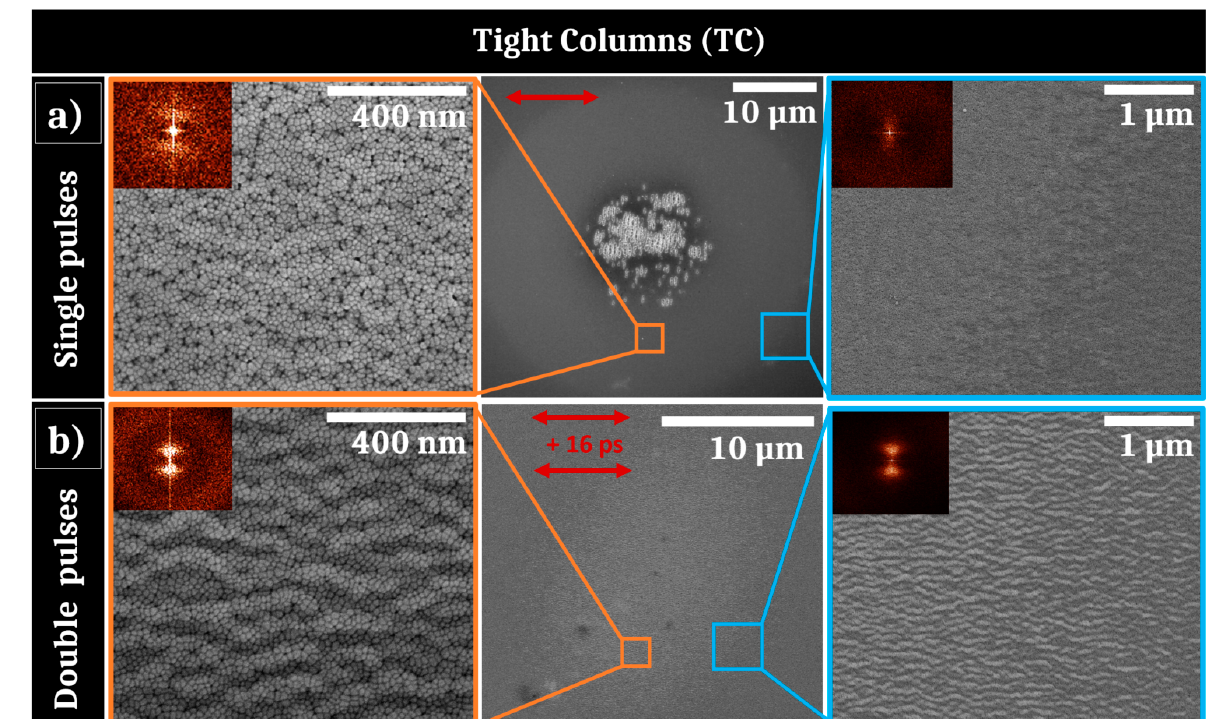
Figure 5. ( a ) SEM pictures of irradiated area of the Tight Columns sample after 50 single pulses of laser irradiation with 0.06 J/cm 2 with 2D-Fourier transform as insets; ( b ) SEM pictures of irradiated area after 50 double pulses of laser irradiation separated by 16 ps with a total fluence of 0.06 J/cm 2 with 2D-Fourier transform as insets. The red arrows represent the electric field